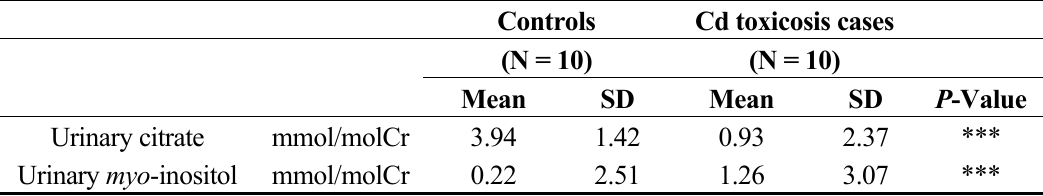
Table 2. Comparison of urinary citrate and myo -inositol concentrations measured by quantification analysis using